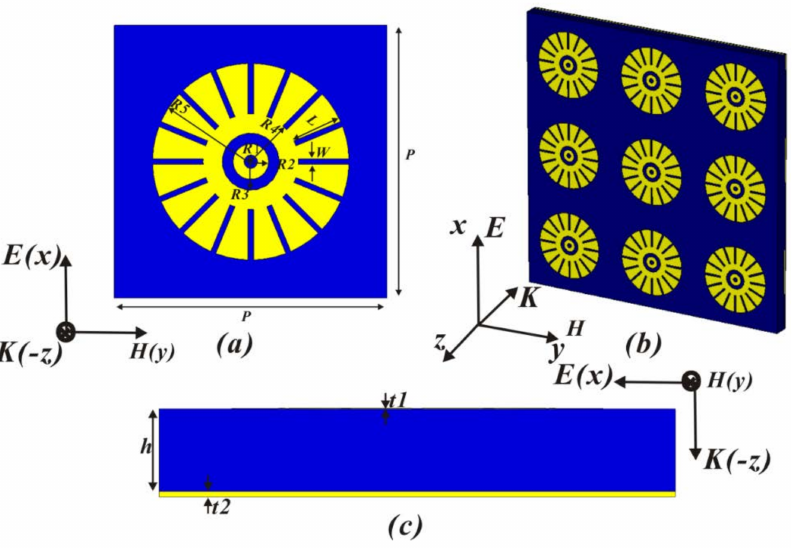
Figure 1. ( a ) Top view of unit cell of THz metamaterial absorber (MA) with sixteen-circular-sector resonator, ( b ) 3D view of THz MA, ( c ) cross section of unit